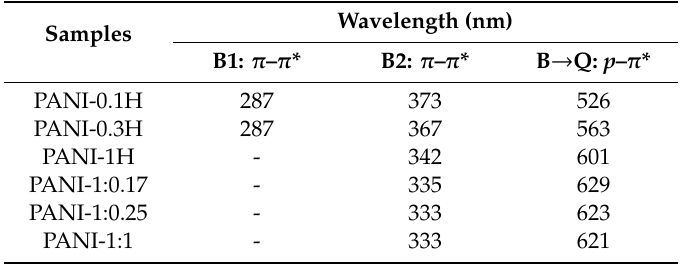
Figure 2. UV − vis spectra of PANIs synthesized at di ff erent reaction conditions. ( a ) Di ff erent HCl concentrations; ( b ) Di ff erent molar ratio of aniline / APS. Table 3. Characteristic peaks of PANIs investigated using UV–vis spectra.